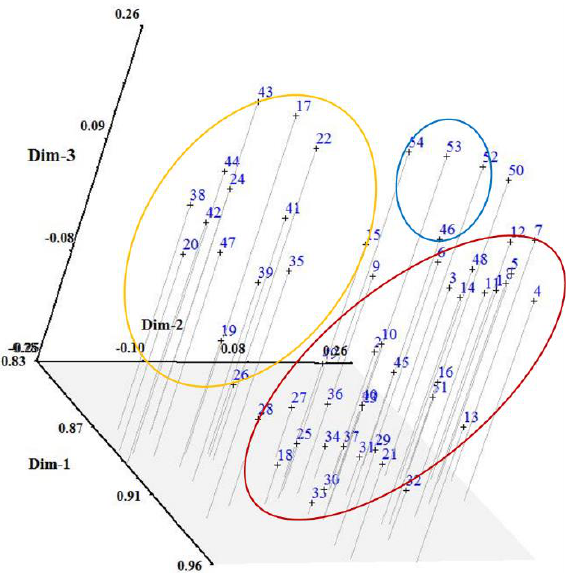
Figure 5. Three-dimensional plot of 54 R. communis L. seed samples (Table 1) based on the principal coordinate analysis using Jaccard similarity coefficient of the ISSR markers.